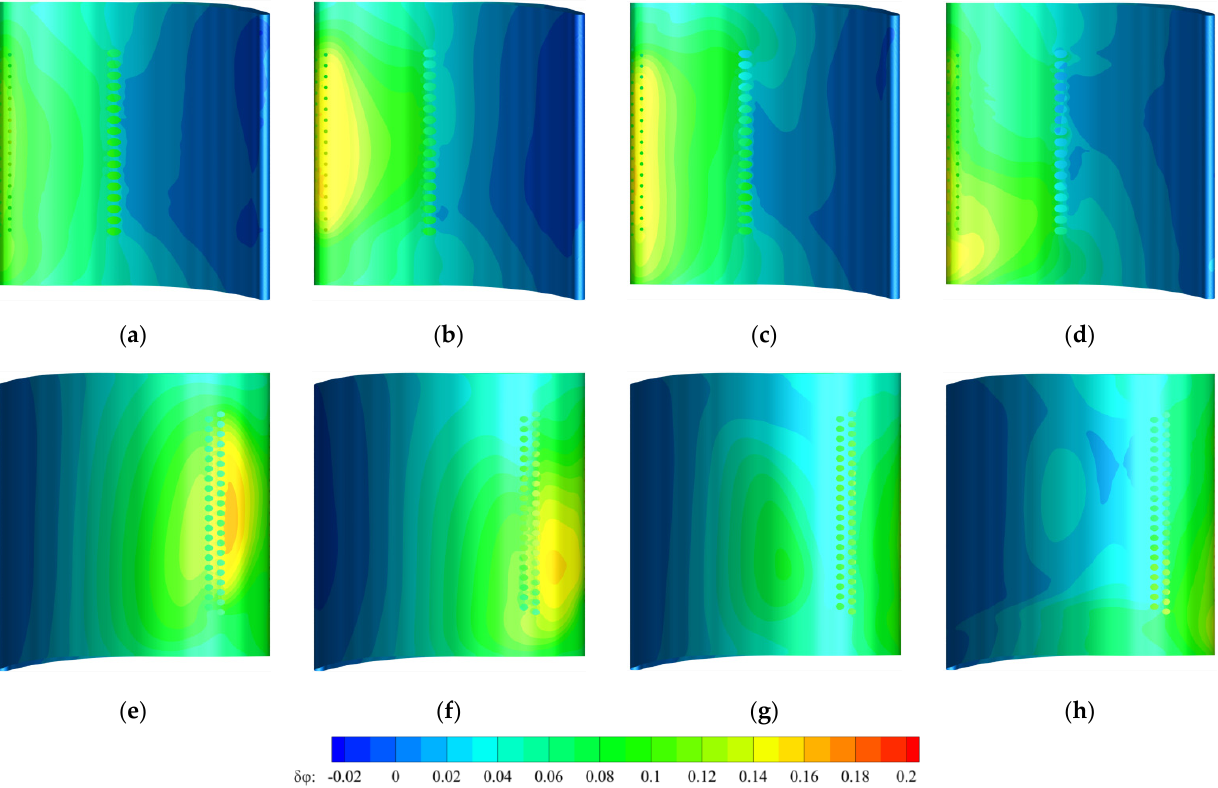
Figure 14. The increment in overall cooling effectiveness at different relative stator–rotor locations. ( a ) Pressure Side At 0/4 T ; ( b ) Pressure Side At 1/4 T ; ( c ) Pressure Side At 2/4 T ; ( d ) Pressure Side At 3/4 T ; ( e ) Suction Side At 0/4 T ; ( f ) Suction Side At 1/4 T ; ( g ) Suction Side At 2/4 T ; ( h ) Suction Side At 3/4 T .